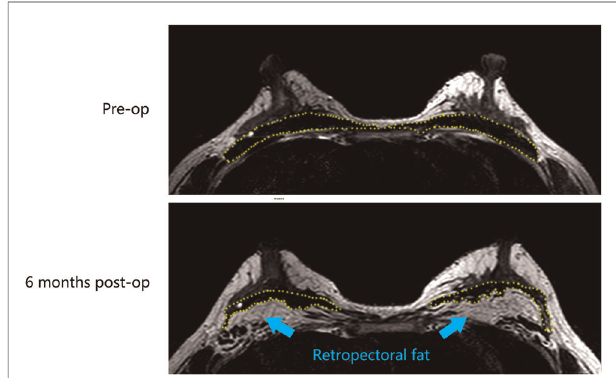
FIGURE 4 | Magnetic resonance images show that a thick fat pad has survived under the pectoral major 6 months after fat grafting. The yellow- dotted line indicates the border of the pectoral major muscle.